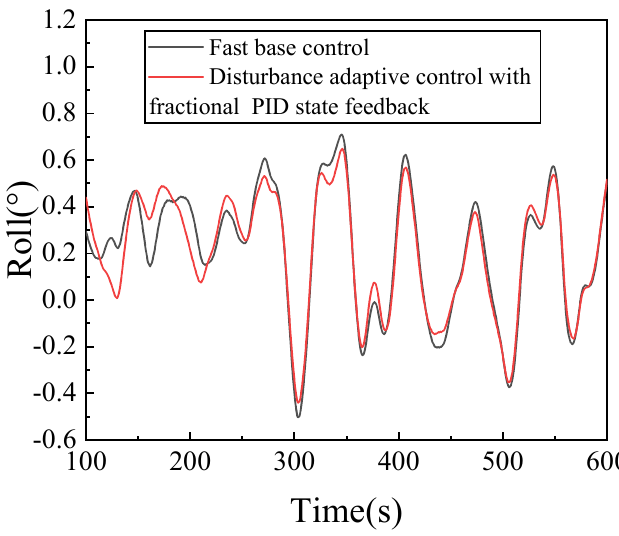
Figure 12. Comparison of sway angles under two different control algorithms.